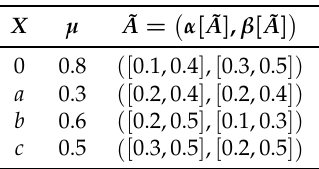
Table 2. Tabular representation of A = (cid:104) µ , ˜ A (cid:105)